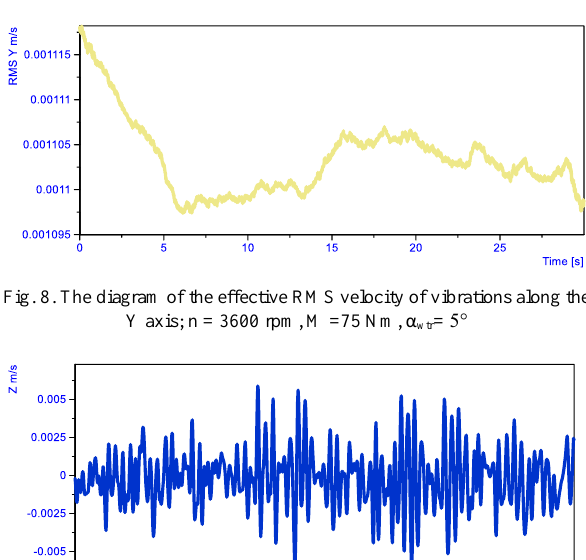
Fig. 12. The diagram of the effective RMS acceleration of vibrations along the Y axis; n = 3600 rpm, M =75 Nm, α wtr = 5° Fig. 7. The diagram of the vibration velocity in the Y axis; n = 3600 rpm, M =75 Nm, α wtr = 5°